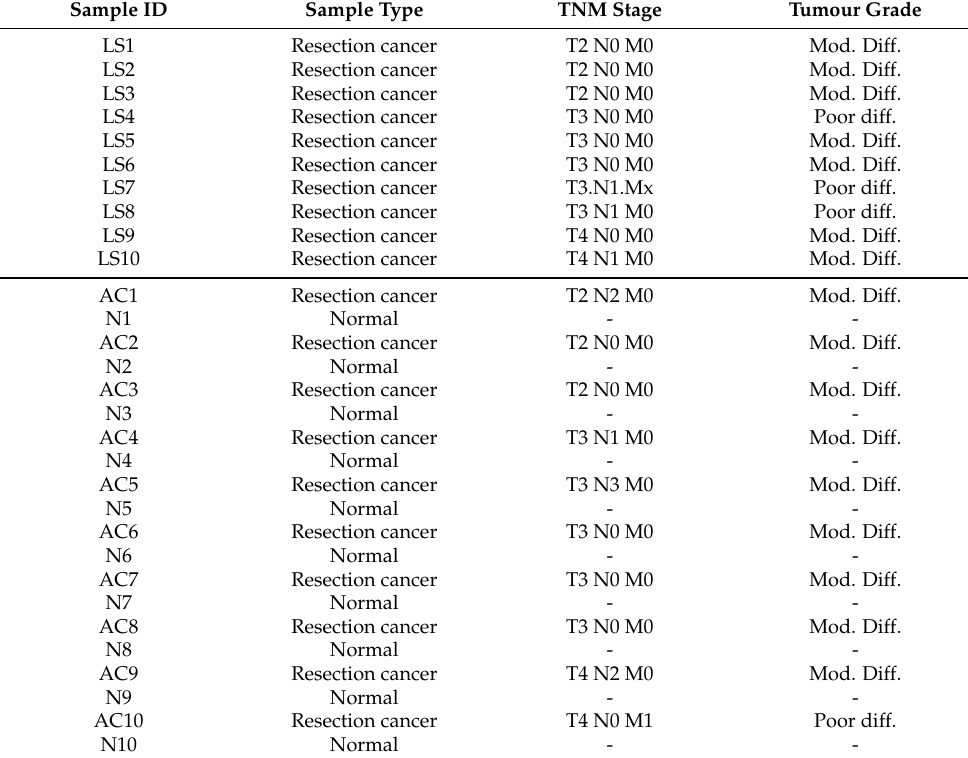
Table A2. Breakdown of patient samples used to build the ML models for the classification of normal (N), sporadic adenocarcinoma (AC) and Lynch syndrome (LS)